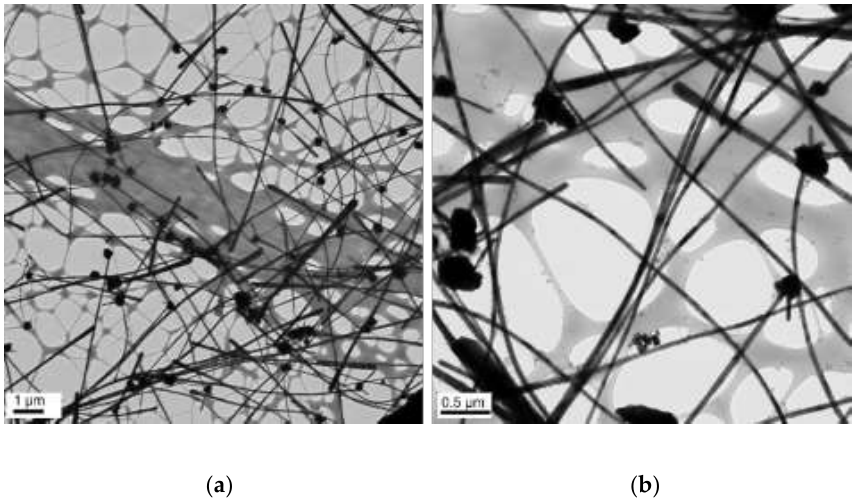
Figure 13. TEM images of copper nanowires with 9 M of NaOH: ( a ) scale bar 1 µ m; ( b ) scale bar 0.5 µ m.